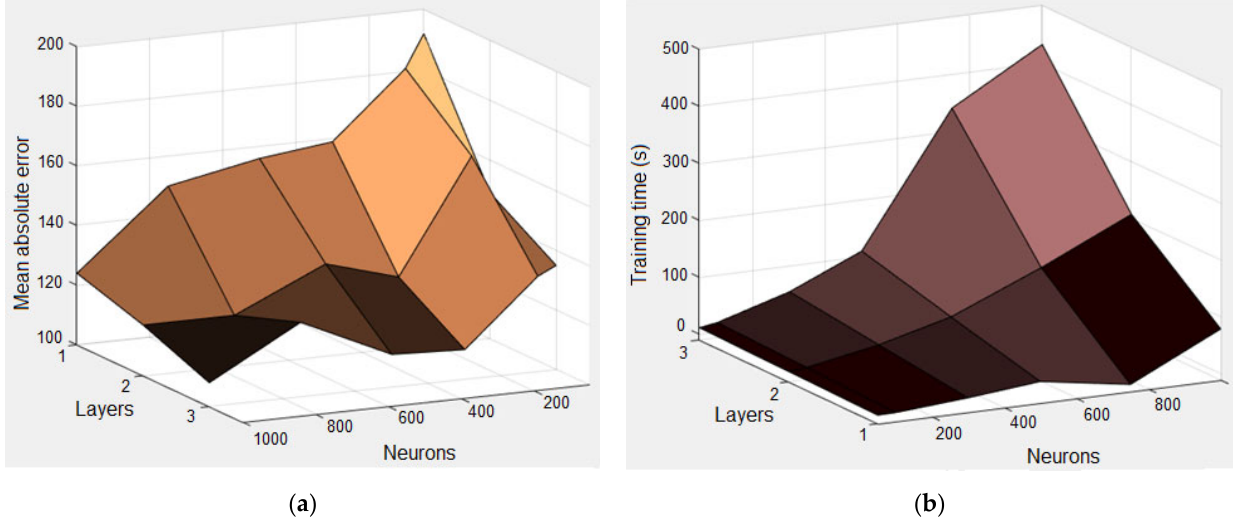
Figure 9. Distribution fields: ( a ) for the mean square error m ae of calculating the number of vehicles; ( b ) for the training time of a three-layer neural network.